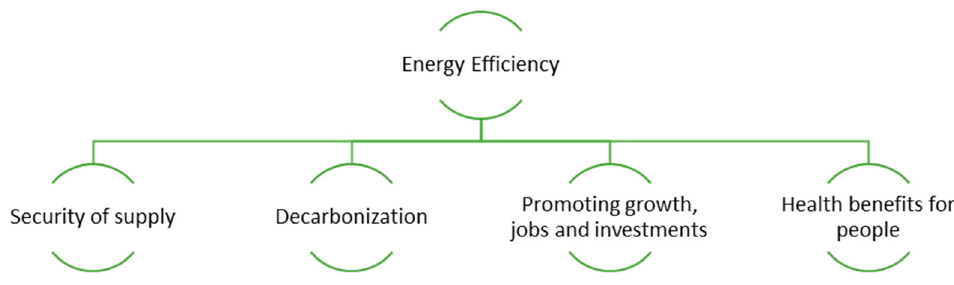
Figure 6. Multiple Energy Efficiency associated benefits.